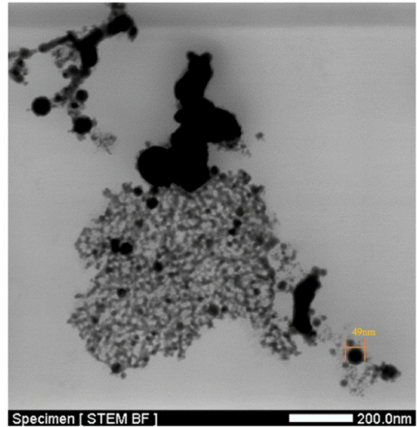
Figure 12. Macroscopic TEM image of bismuth nanoparticles.